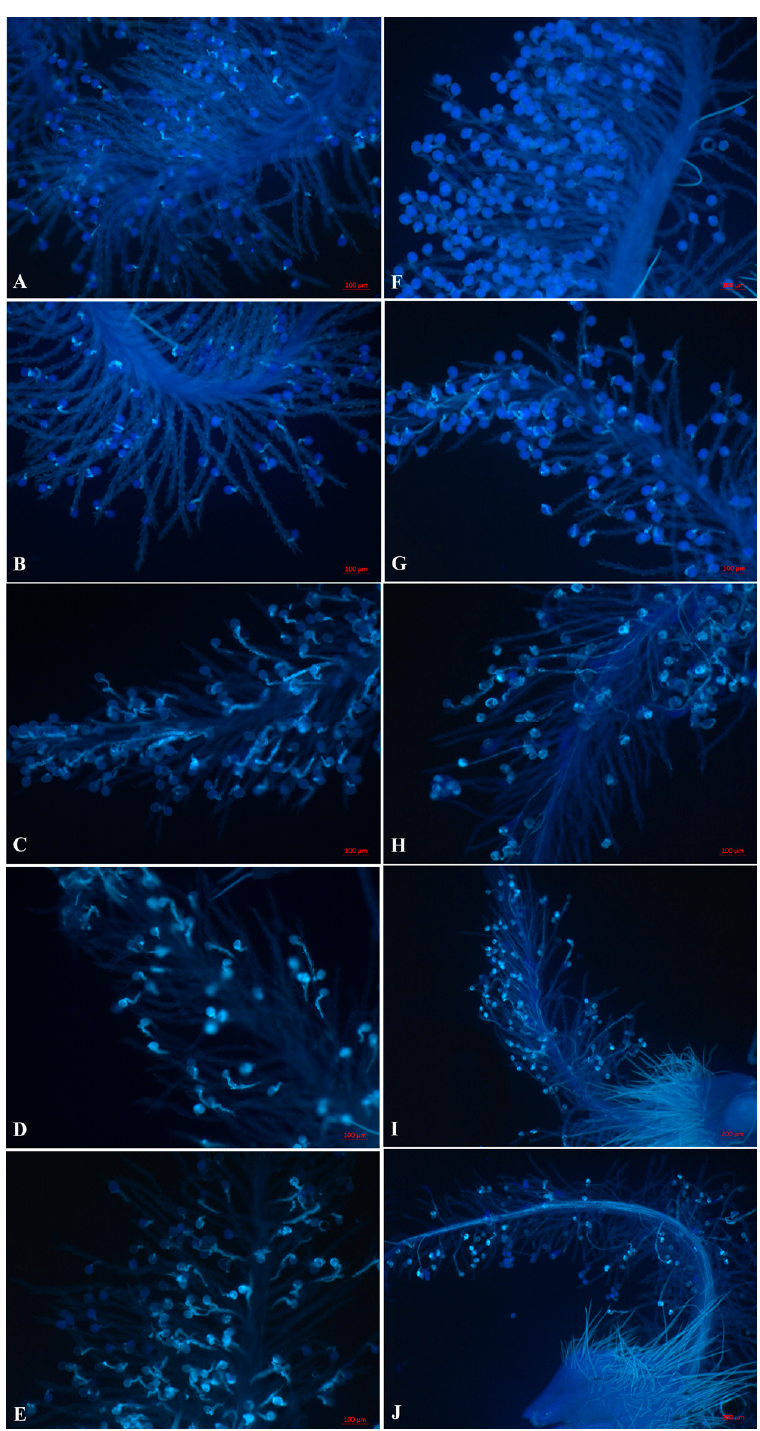
Figure 1. Pollen tube growth was observed under UV fluorescent microscopy. ( A – E ) Self-pollinated pistils at 5 min, 10 min, 30 min, 1 h, and 2 h, respectively. Pollen grains germinated normally, but the pollen tubes were soon inhibited at or near the stigma surface and may block with callose. Subsequently, pollen tubes nearly stopped growth at 30 min, and few pollen tubes reached into the style. ( F – J ) Cross-pollinated pistils at 5 min, 10 min, 30 min, 1 h, and 2 h, respectively. Pollen grains and pollen tubes germinated and grew normally. A majority of pollen tubes reached the style base at 1–2 h after cross-pollination. Bars: A–H, 100 μ m; I–J, 200 μ m.